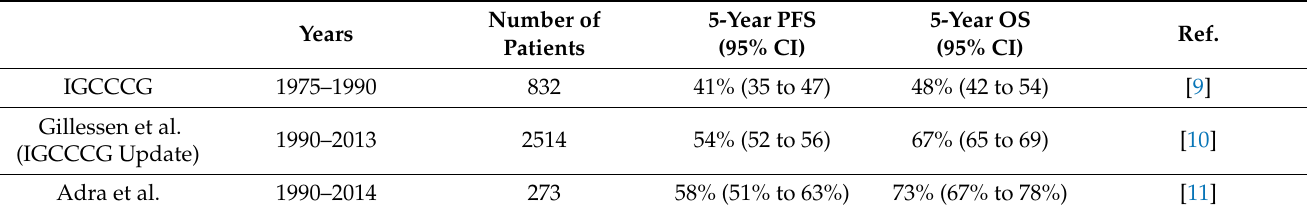
Table 1. Survival updates on poor-risk